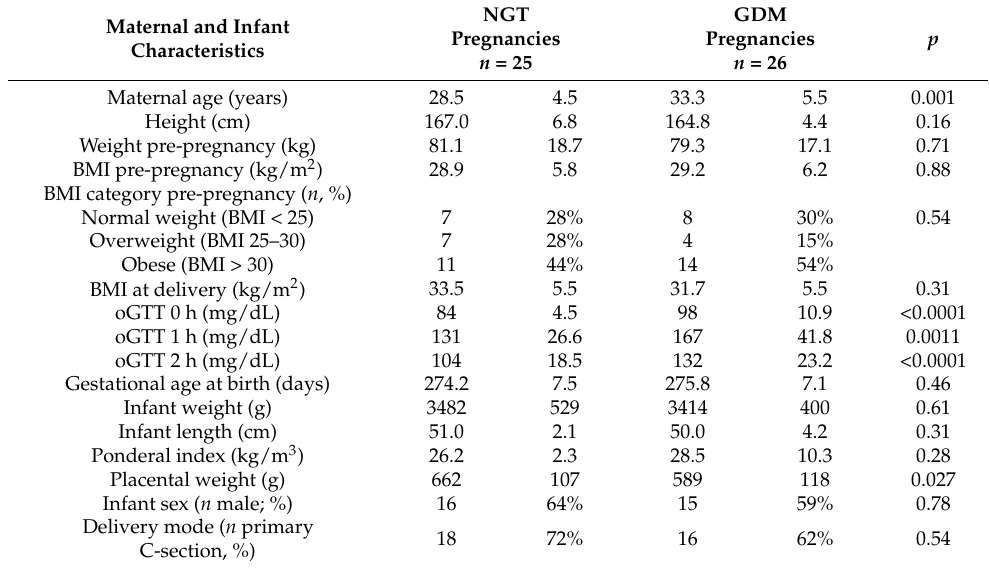
Table 1. Subject